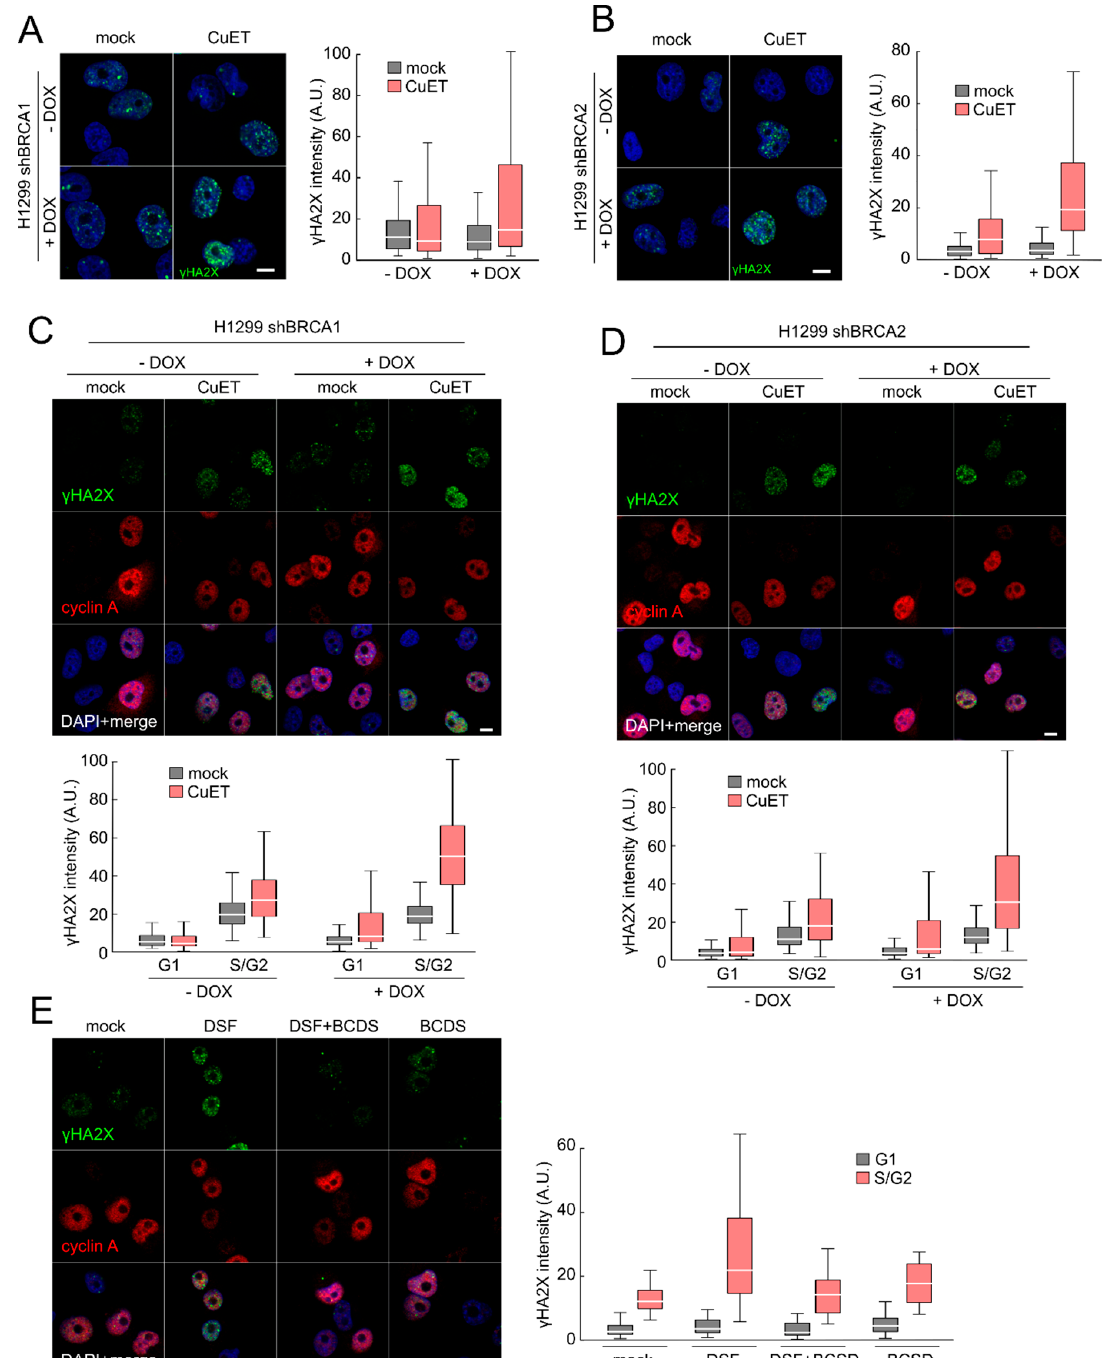
Figure 1. Disulfiram’s metabolite bis-diethyldithiocarbamate-copper complex (CuET) causes DNA damage preferentially in S/G2 cells deficient for BRCA1 or BRCA2 proteins. H1299 cells expressing (doxycycline-) DOX-inducible shBRCA1 ( A ) or shBRCA2 ( B ) were cultivated for at least three days in DOX-containing media and then treated with CuET (250 nM) for 5 h, and γ H2AX intensity was analyzed by quantitative microscopy. ( C ) H1229 shBRCA1 cells or ( D ) H1299 shBRCA2 cells were treated as in (A) a γ H2AX intensity was quantified with respect to cyclin A positivity defining S/G2 phase. ( E ) H1229 shBRCA2 cells pre-incubated with DOX were treated with disulfram (DSF) (500 nM), bathocuproinedisulfonic acid (BCDS) (50 μ M), or their combination for 5 h and γ H2AX intensity was quantified. Box plot represents 25–75 quartiles, median, and whiskers non-outlier range. Scale bars = 10 μ m.